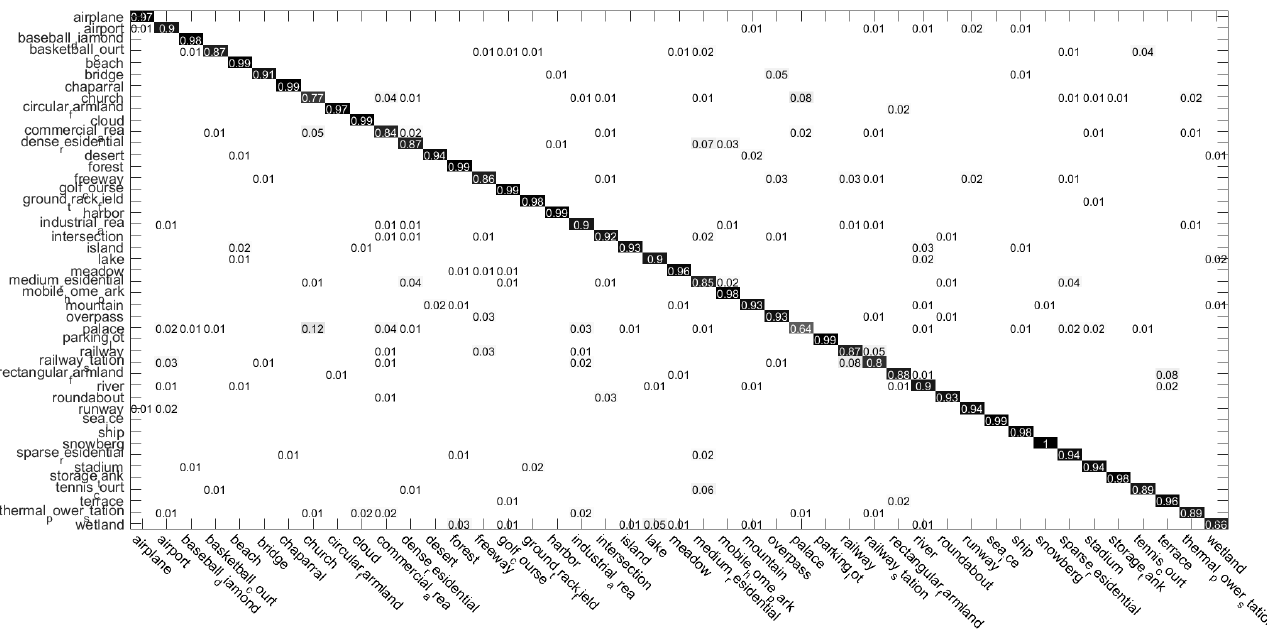
Figure 9. Confusion matrix of the proposed method on the NWPU-RESISC45 dataset under the training ratio of 10%.